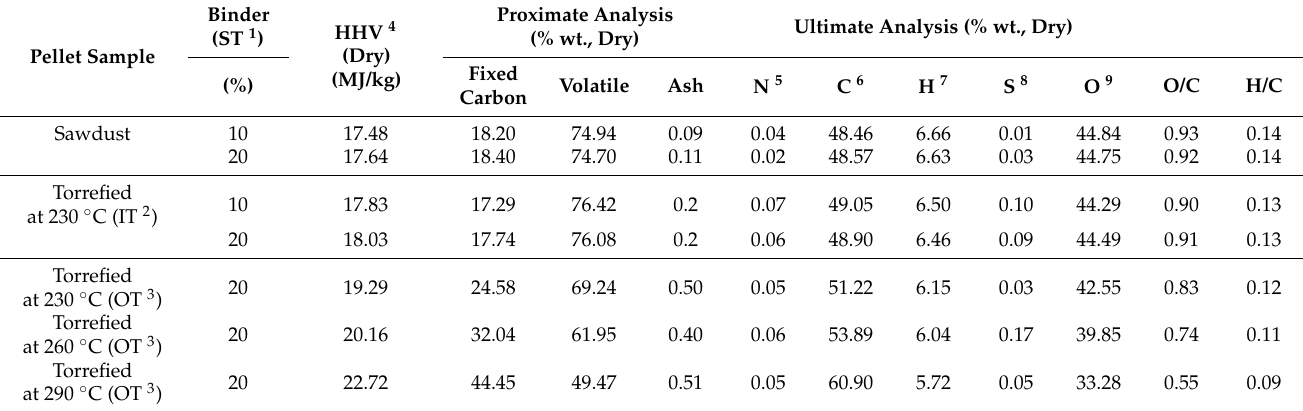
Table 8. Thermochemical features of torrefied and non-torrefied